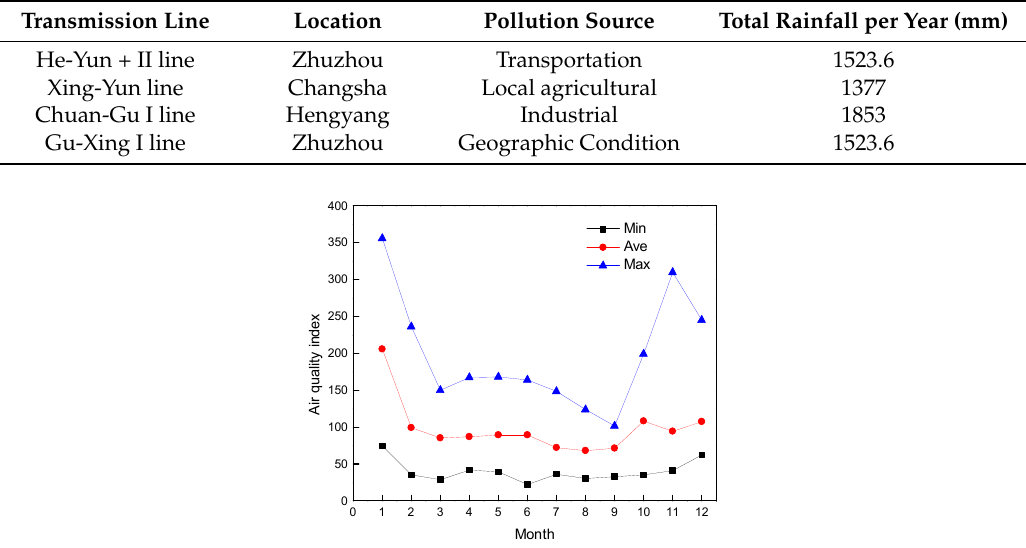
Table 2. Information of the experimental sites.